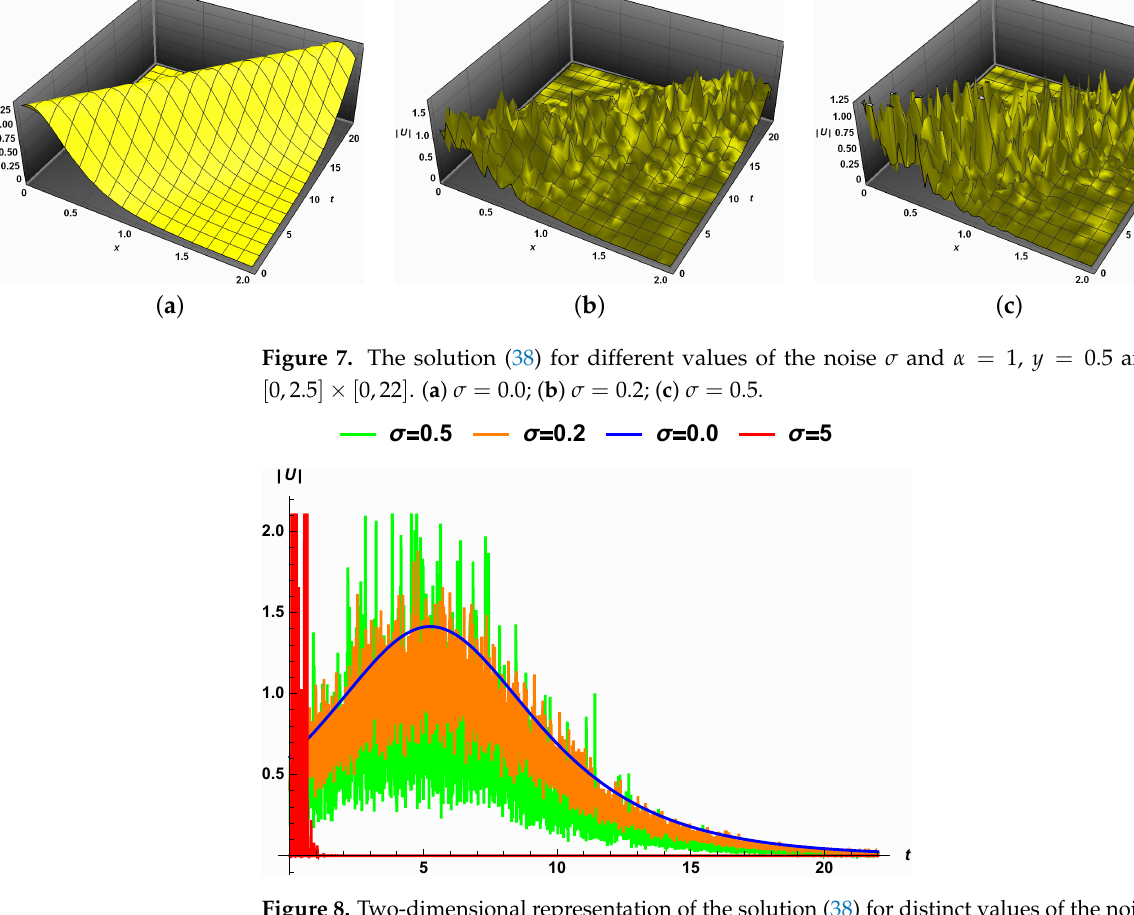
Figure 8. Two-dimensional representation of the solution (38) for distinct values of the noise σ , α = 1, x = 1, y = 0.5, and t ∈ [ 0,22 ]